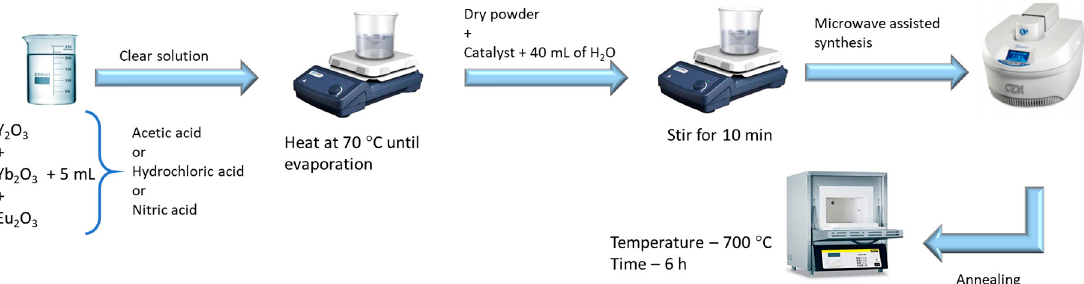
Figure 1. Schematic of Yb/Eu doped Y 2 O 3 nanostructures produced by a hydrothermal process under microwave irradiation.